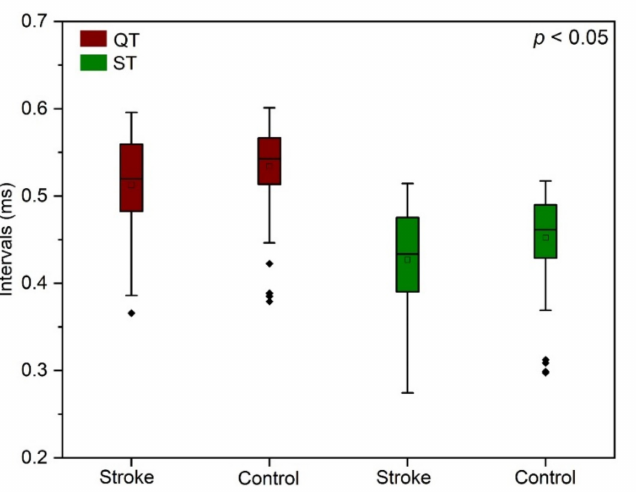
Figure 6. Boxplot illustration of the distribution of QT ( p = 0.029) and ST intervals ( p = 0.014) between the stroke and the control